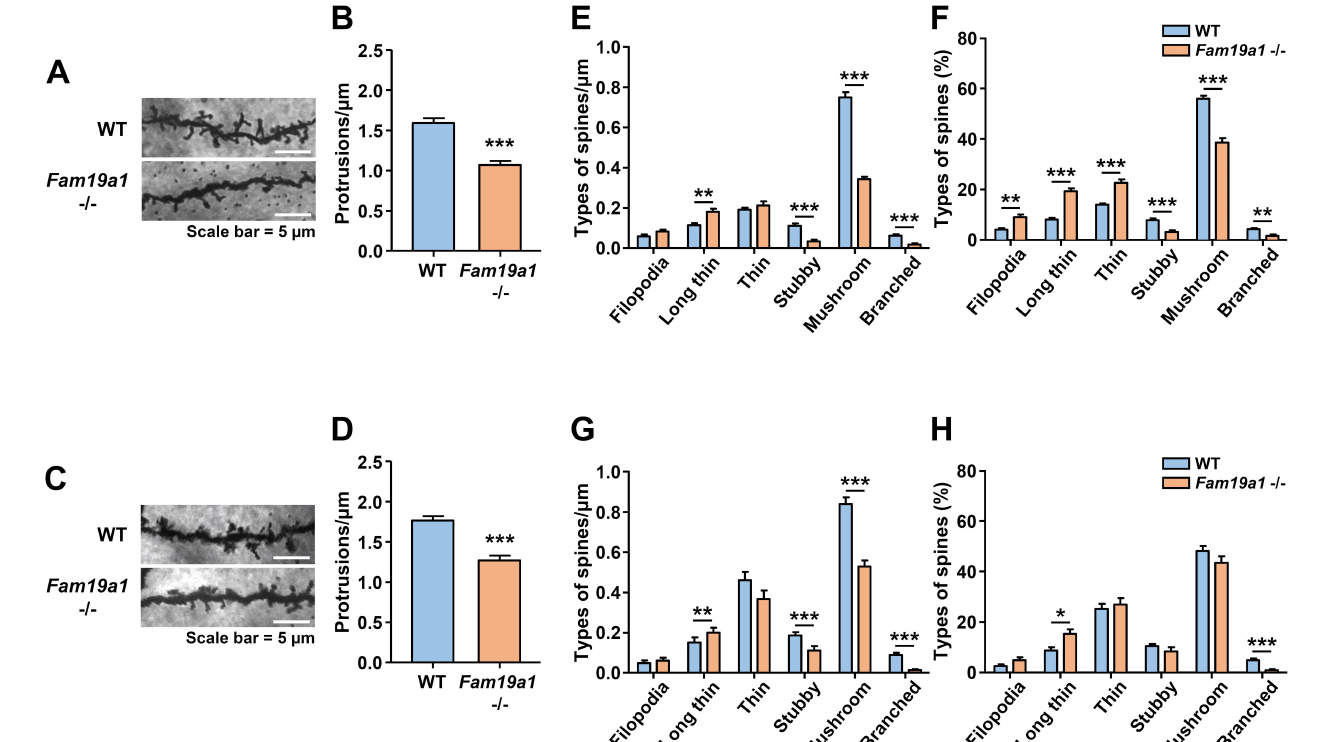
Figure 1. Abnormalities in dendritic spines of cortical layer 5 (L5) pyramidal neurons in adult Fam19a1 − / − mice (postnatal day 63). ( A ) Representative images and ( B ) protrusion density of apical dendritic spines of cortical L5 neurons. ( C ) Representative images and ( D ) protrusion density of basal dendritic spines of cortical L5 neurons. ( E ) Density and ( F ) percentage of each spine type among apical dendritic spines of cortical L5 neurons. ( G ) Density and ( H ) percentage of each spine type among basal dendritic spines of cortical L5 neurons. For each experimental group, three mice were analyzed. Data are presented as means ± standard errors of means (SEM). * p < 0.05, ** p < 0.01, *** p < 0.001 versus WT mice by the Student’s t test or Mann–Whitney test with Bonferroni